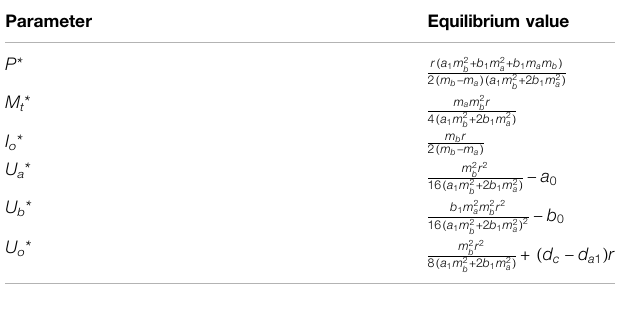
TABLE 2 | Equilibrium values in Scenario I. Parameter Equilibrium value